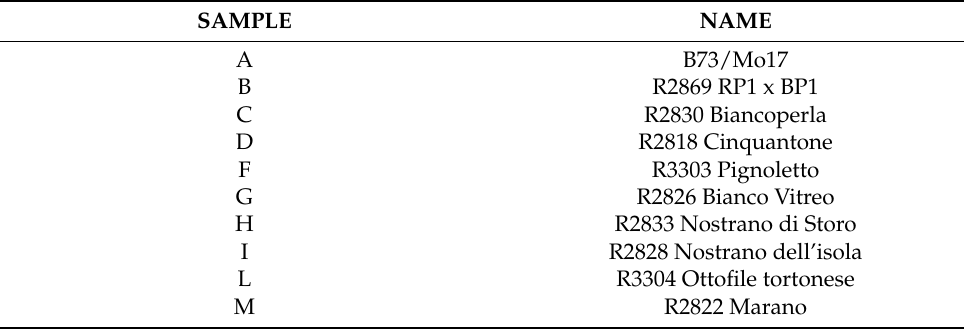
Table 1. List and relative codename of the analyzed maize local varieties.